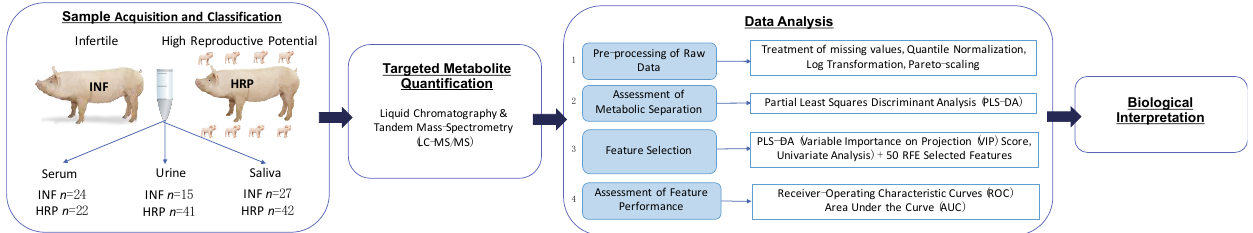
Figure 1. Flow of the study. Pigs were sampled for saliva, urine and serum as outlined in the methods section. After sampling, pigs were classified into their respective group based on their past reproductive performance. Samples were analyzed with targeted metabolomic quantification using LC-MS/MS techniques. Raw data from this analysis was appropriately pre-processed and analyzed using our developed metabolomics protocol. Metabolomics analysis results were then interpreted in the context of biological relevance of sow reproduction.